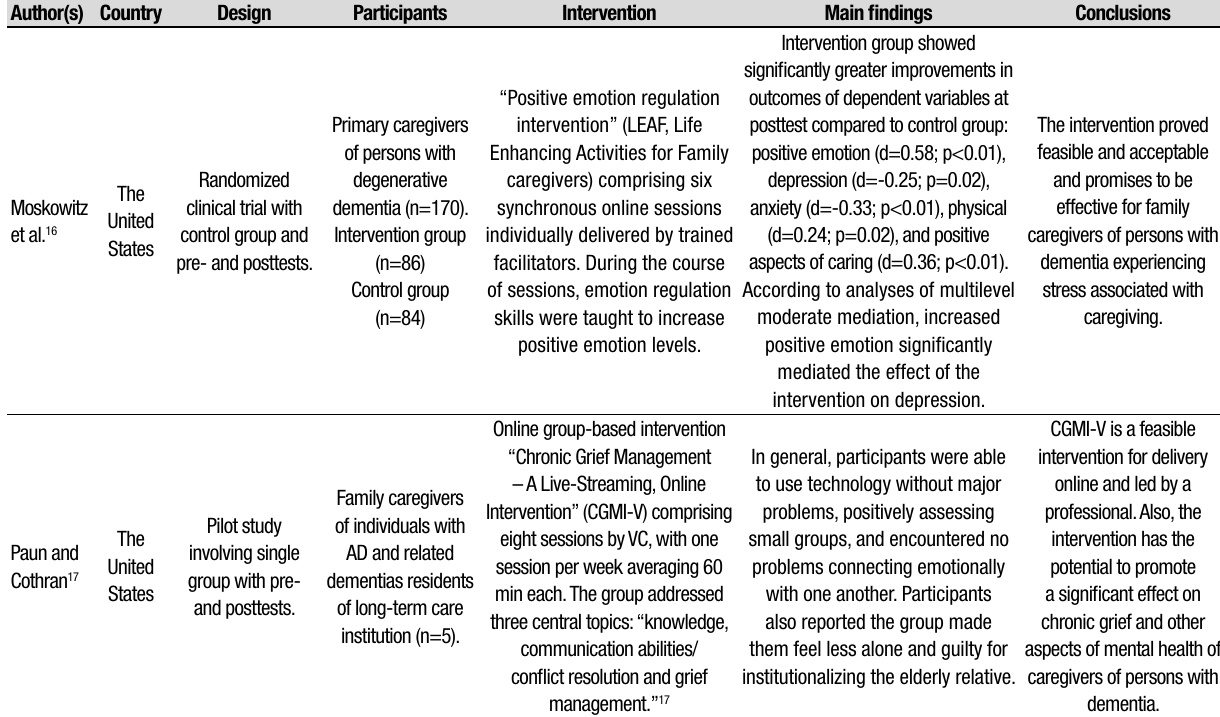
BPSD: Behavioral and Psychological Symptoms of Dementia; VC: videoconferencing.